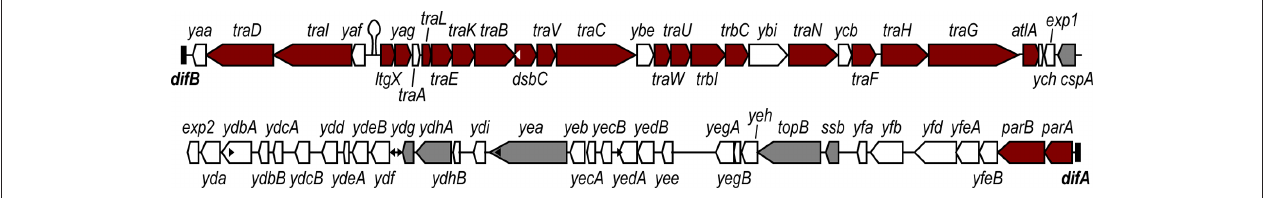
FIgure 1 | Map of the gonococcal genetic island (ggI) from N. gonorrhoeae strain MS11. The GGI in N. gonorrhoeae strain MS11 is 57 kb and is inserted in the chromosome at the dif site. The GGI encodes many homologs of type IV secretion system genes (red), as well as 33 genes of unknown function (white). There are six genes encoding homologs for DNA-binding or processing proteins (gray). In this map, traA is colored white despite encoding a homolog for the conjugative pilin subunit because it is not required for DNA secretion. The genes for the lytic transglycosylase AtlA